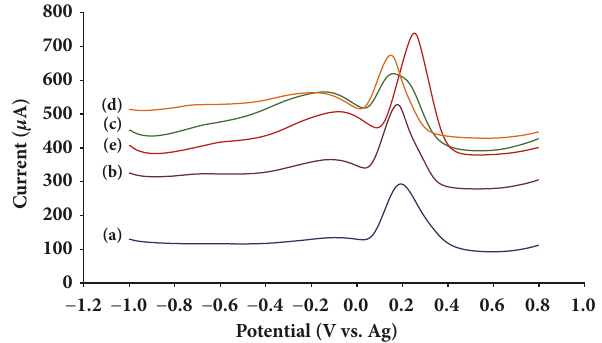
Figure 5: Square-wave voltammograms of (a) bare SPCE, (b) GO/SPCE, (c) PDA-rGO/SPCE, (d) GO/Au/SPCE, and (e) PDA- rGO/Au/SPCE in 0.1 M PBS pH 6.0 containing 1 mM uric